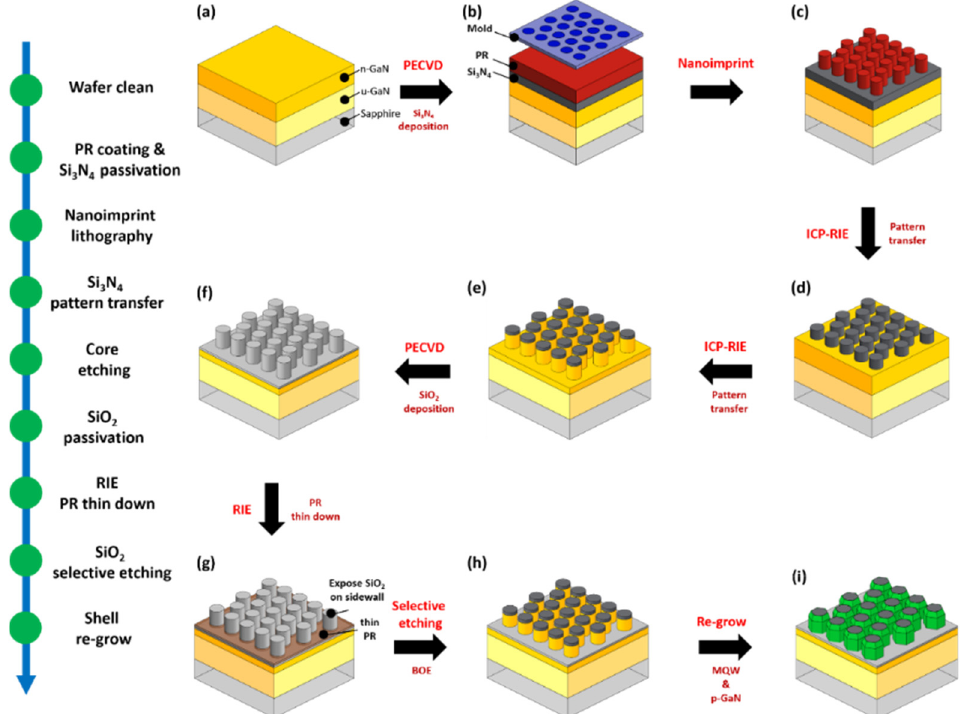
Figure 1. Schematic process flow of 3D core–shell nanorod LED. ( a ) The epitaxial structure; ( b ) deposit Si 3 N 4 on the n-GaN as passivation layer; ( c ) nanoimprint lithography process to produce a nanorod array; ( d , e ) transfer the pattern by SiO 2 hard mask deposition; ( f ) deposit SiO 2 and a thicker photoresist (PR) layer; ( g ) expose the SiO 2 on the sidewalls of the nanorod; ( h ) selective removal of SiO 2 on the sidewalls of the nanorod; ( i ) completed device.